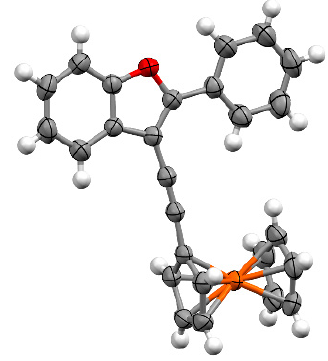
Figure 1. Molecular structure of compound 9 . Thermal ellipsoids are shown at 50% probability level.